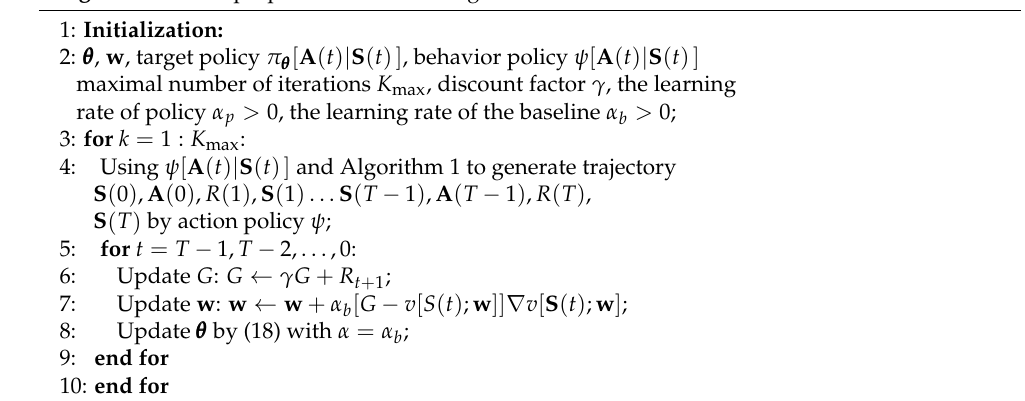
Algorithm 2 : The proposed DRL-based